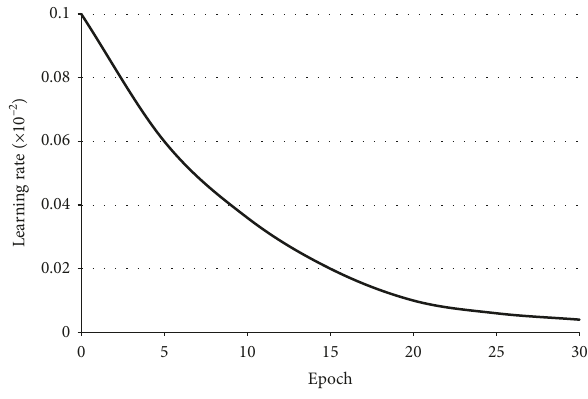
Figure 9: Learning rate.